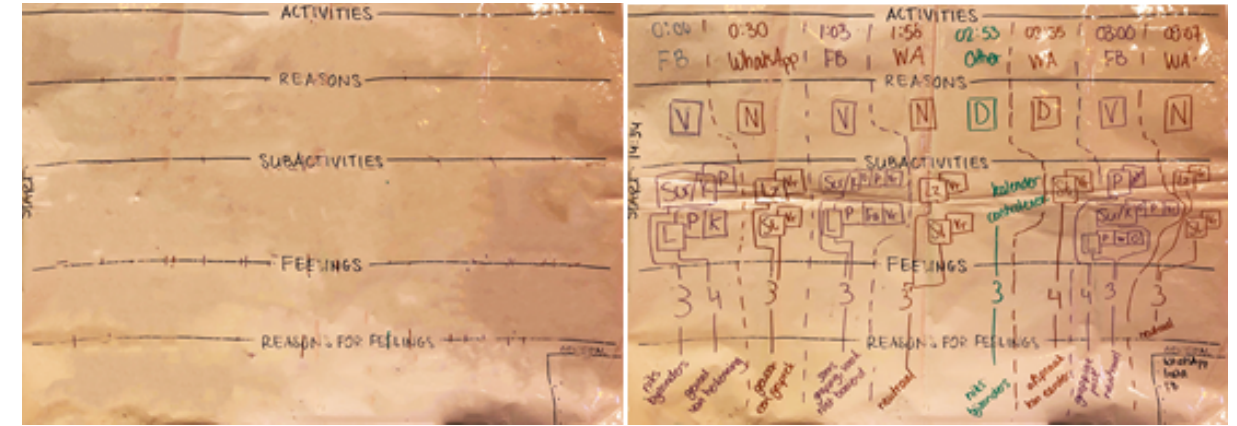
Figure 5. Left panel: empty whiteboard foil sheet prepared for the stimulated recall interview with the basic skeleton already drawn on it. Right panel: completed example of the stimulated recall chart. Major activities are indicated in the top row; reasons to engage in these activities are indicated in the second row (N: due to a notification; V: boredom); specifics surrounding the activities are indicated in the third row (Scr/K: passive viewing; L: like); and the fourth and fifth rows contain information about participants’feelings during these activities (on a scale from 1-5, with a brief